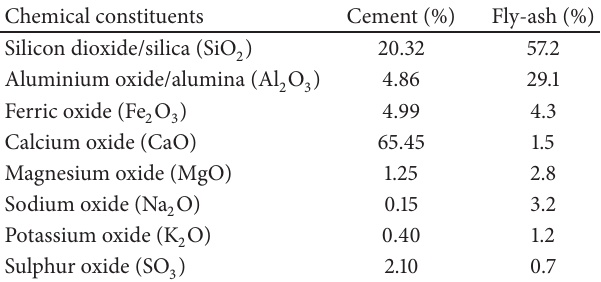
Table 3: Chemical compositions of cement and fly-ash.